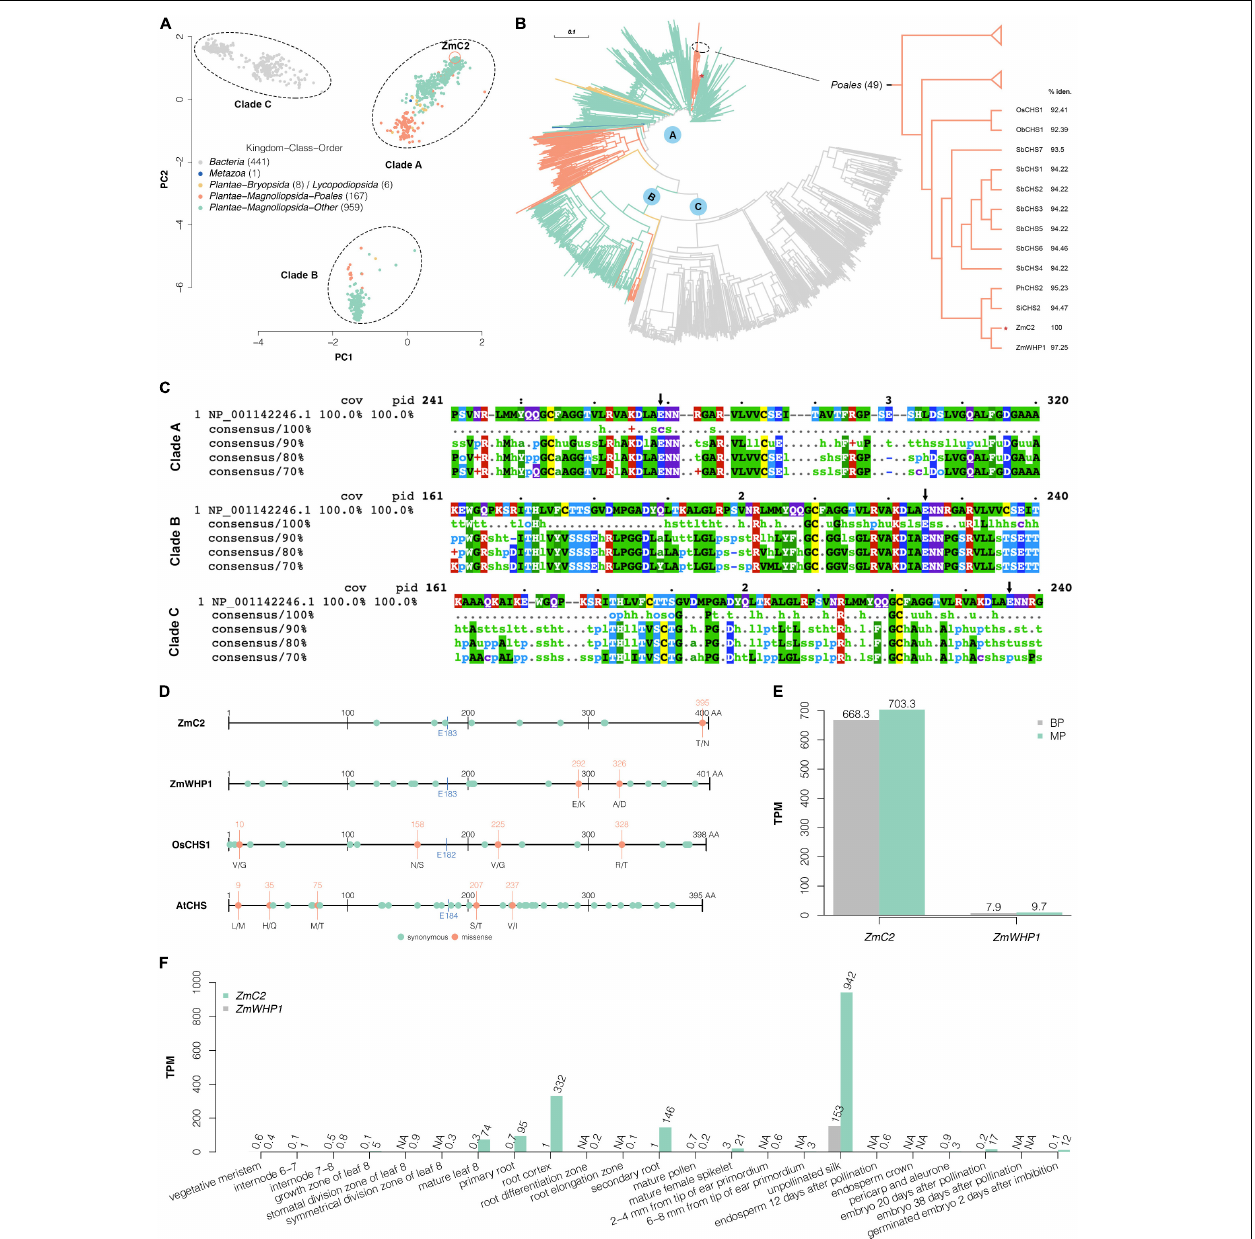
FIGURE 5 | Conservation analysis of ZmC2 and E183 site. (A) Principal component analysis after multiple alignment of ZmC2 and its 1581 homologs. The dots are colored based on Kingdom-Class-Order of these proteins’ species. (B) Phylogenetic tree of ZmC2 and its homologs. The branch colors are consistent with dot colors in (A) . The right panel is a pruned view of 49 proteins belonging to Poales (class) containing ZmC2. OsCHS1, chalcone synthase 1 ( Oryza sativa Japonica Group ) (NCBI accession: XP_015618054.1); ObCHS1, PREDICTED: chalcone synthase 1 ( Oryza brachyantha ) (NCBI accession: XP_006662967.1); SbCHS1-7, chalcone synthase 1-7 ( Sorghum bicolor ) (NCBI accession: XP_002450874.1, XP_002450871.1, XP_002450875.1, XP_002450870.1, XP_002449616.1, XP_002450877.1, and XP_002450876.1); PhCHS2, chalcone synthase C2 ( Panicum hallii ) (NCBI accession: XP_025827694.1); SiCHS2, chalcone synthase C2 ( Setaria italica ) (NCBI accession: XP_004979391.1); ZmWHP1, chalcone synthase WHP1 ( Zea mays ) (NCBI accession: NP_001149022.1). % iden. means the percentage of identity of the protein and ZmC2. (C) Mview for multiple alignment of ZmC2 (NCBI accession: NP_001142246.1) and its homologs within each clade. The black arrow labels the corresponding site for ZmC2-E183. (D) Within species’ variations for ZmC2 (Ensembl-Plants accession: Zm00001d052673_T001), ZmWHP1 (Ensembl-Plants accession: Zm00001d007403_T001), OsCHS1 (Ensembl-Plants accession: Os11t0530600-01), and AtCHS (Ensembl-Plants accession: AT5G13930.1). This variation data sets consists of multiple varieties or cultivars and are available at Ensembl-Plants (http://plants.ensembl.org/index.html). The blue line and text labels the corresponding site for ZmC2-E183. (E) RNA-seq results of ZmC2 and ZmWHP1 in the first sheath of B73-type F2 progeny (BP) and mutant-type F2 progeny (MP). (F) Expression pattern of ZmC2 and ZmWHP1 in 23 maize tissues (Walley et al., 2016). The expression information is achieved from Expression Atlas (https://www.ebi.ac.uk/gxa/home; Papatheodorou et al., 2020). NA means data not available.